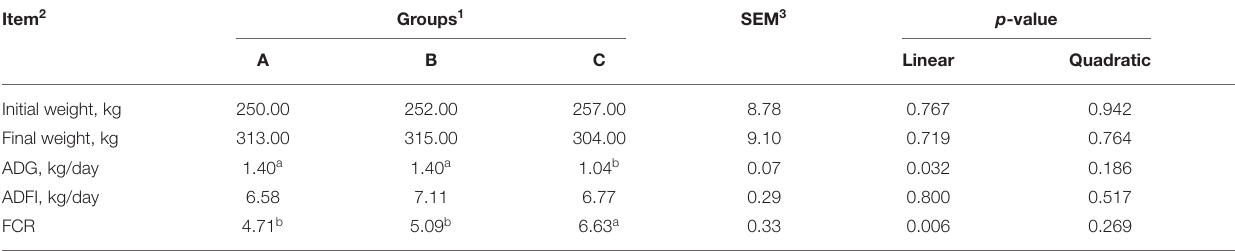
TABLE 2 | Effects of PSR silage on growth performance of Angus beef cattle ( N = 5). Item 2